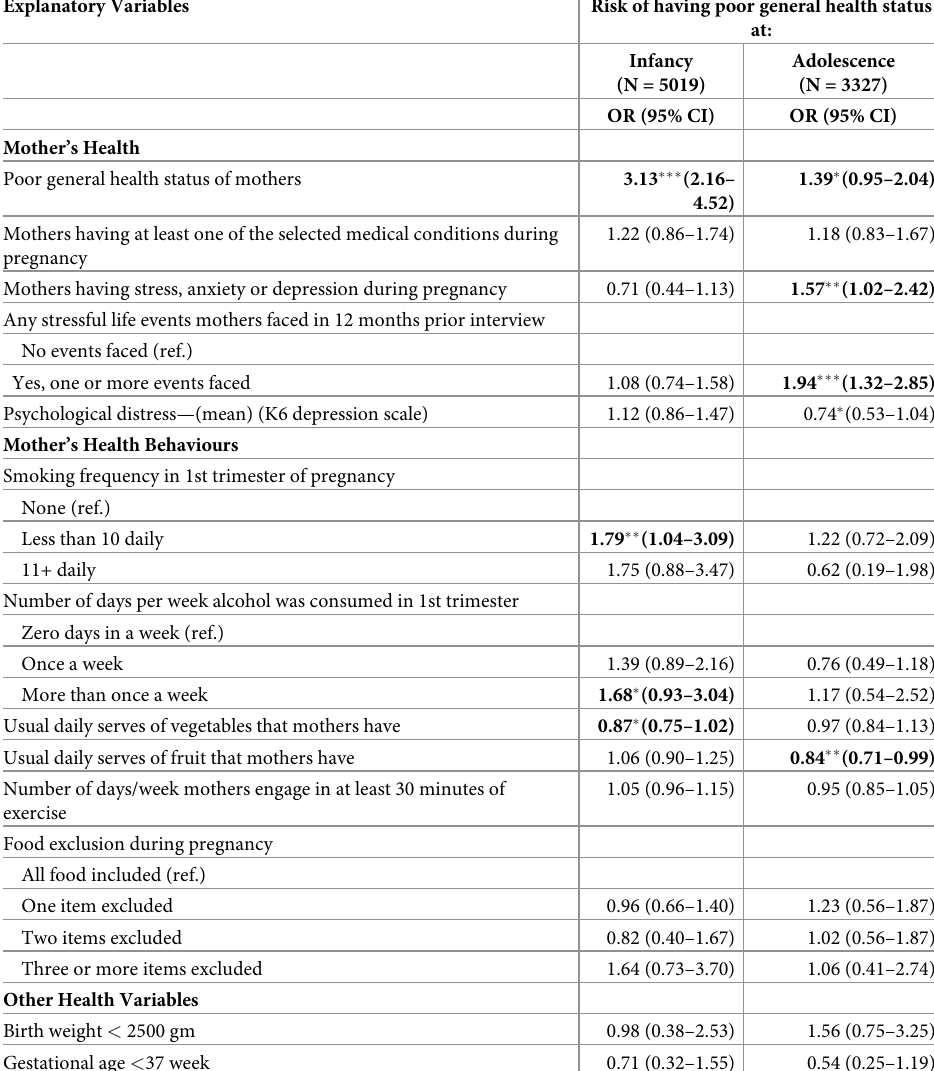
Table 2. Maternal health and health-related behaviours and their associations with children’s general health sta- tus during infancy (0–1 year of age) and adolescence (12–13 years of age). Explanatory